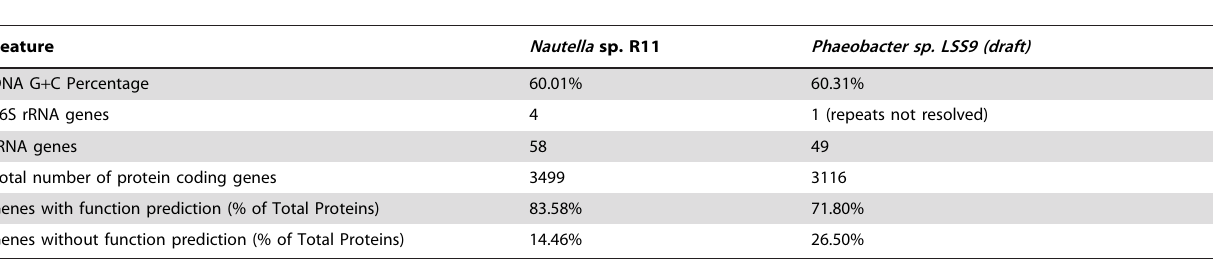
Table 2. General features of the genomes of strains R11 and LSS9.